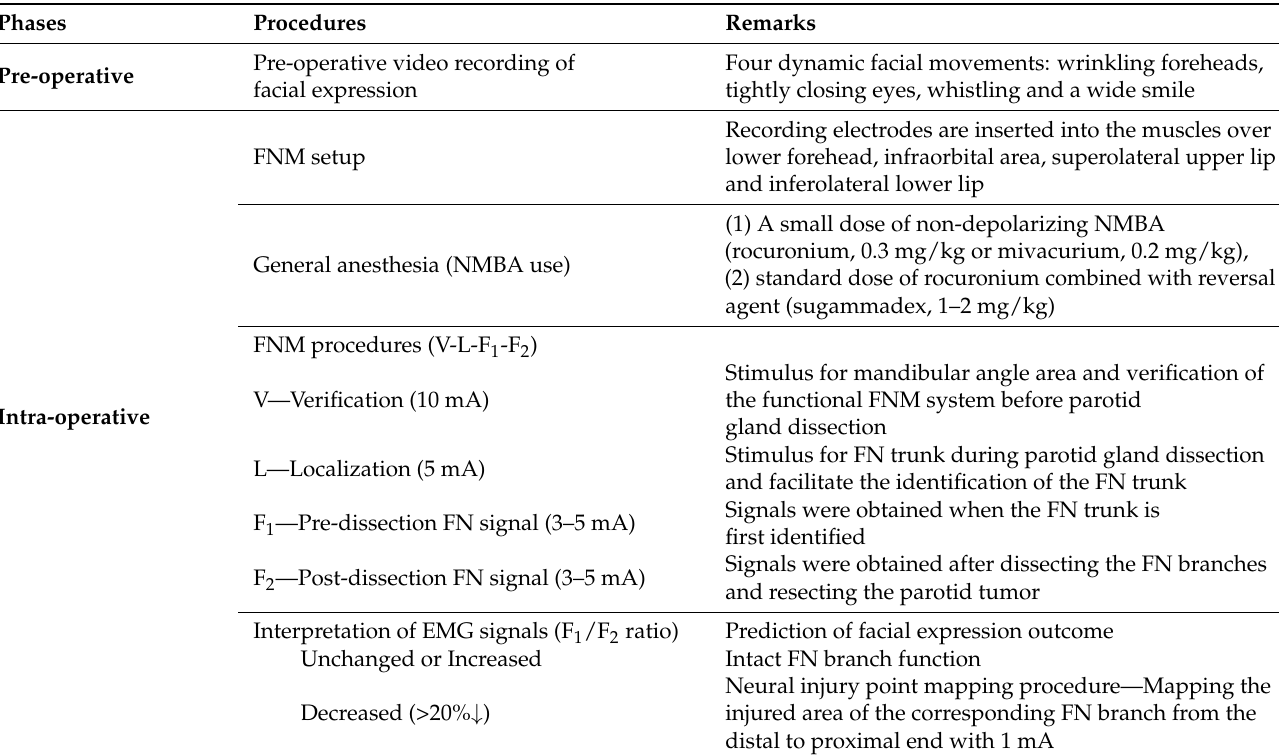
Table 1. Proposals for standardization of intraoperative FNM in parotid